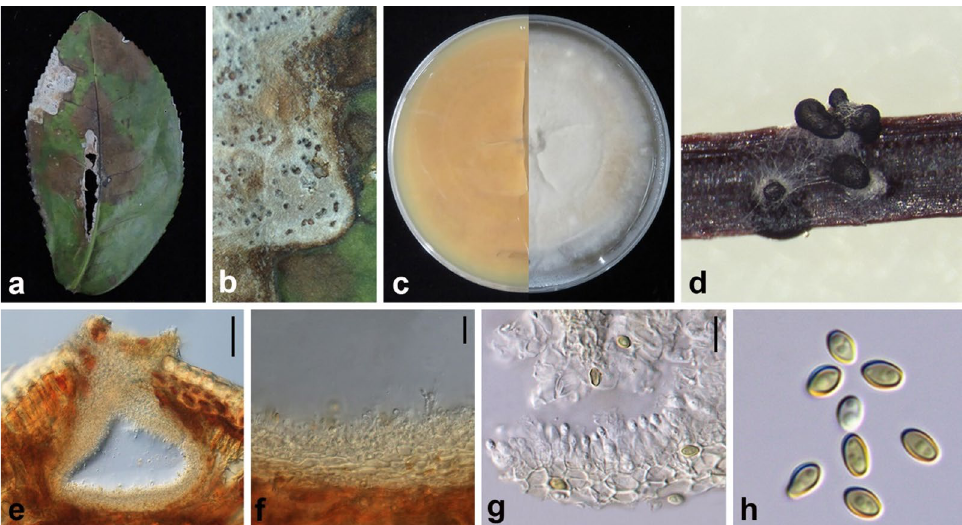
Figure 7. Alloconiothyrium camelliae (NTUH 17-032-1, holotype ). ( a ) Leaf lesions. ( b ) Appearance of conidiomata on host surface. ( c ) Cultures on PDA, from above and below. ( d ) Pycnidia on pine needle. ( e ) Vertical section of conidioma. ( f ) Conidiomatal wall. ( g ) Conidiogenous cells and developing conidia. ( h ) Conidia. Scale bars: ( e ) = 50 μm, ( f , g ) = 10 μm, ( h ) = 5